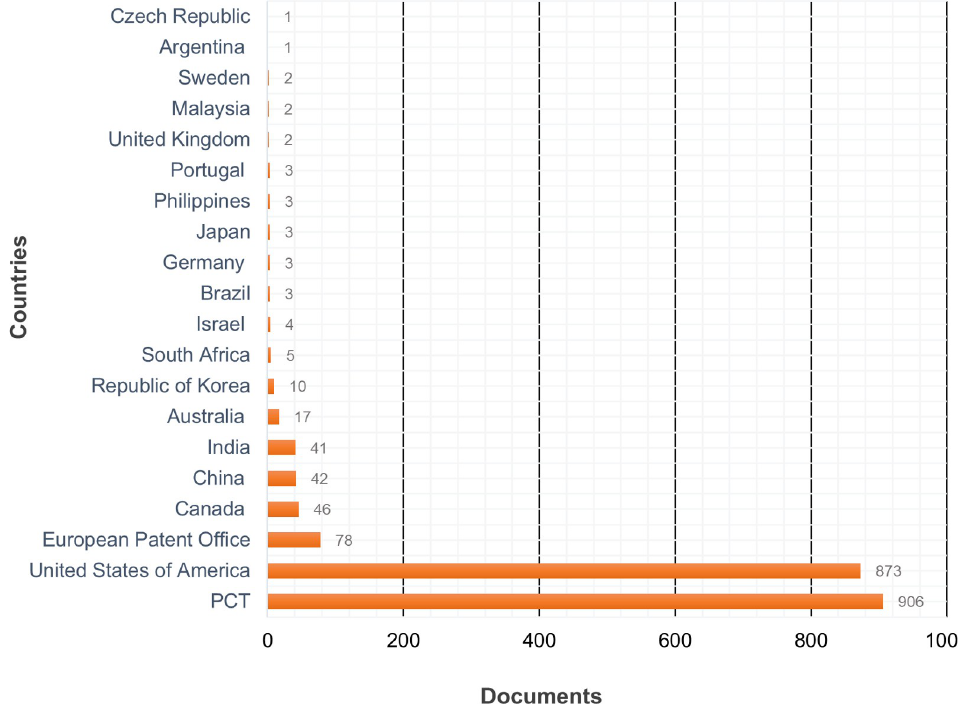
Fig 4. Countries with the highest number of patent documents. Source: Prepared by the authors based on WIPO [28].